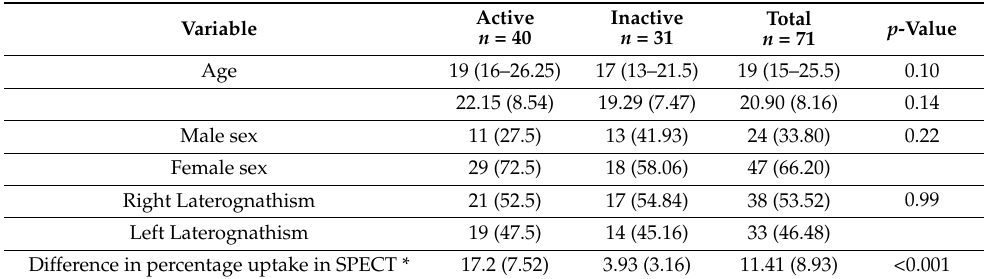
Table 3. General characteristics of the patients with active/inactive condylar hyperplasia. SPECT, single photon emission computed tomography.